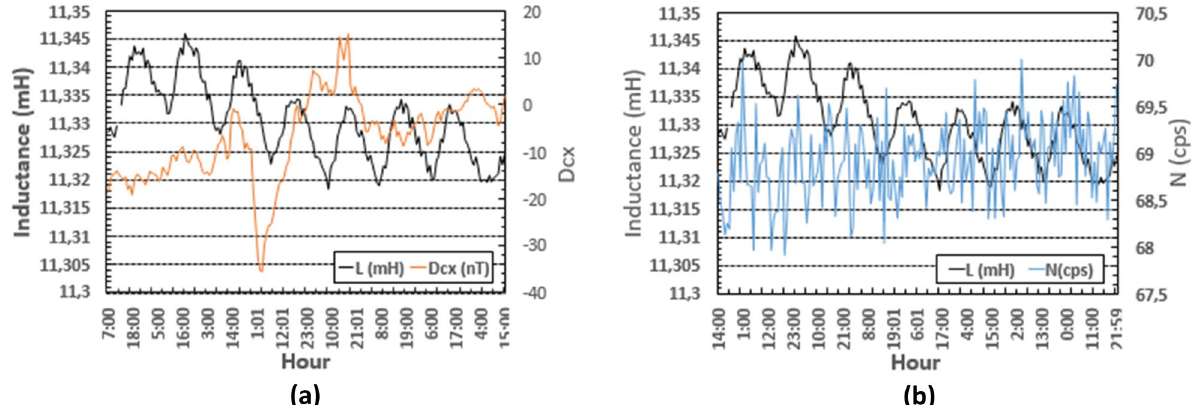
Figure 4. ( a ) Inductance versus Dcx, the latter ranging between − 25 and + 15 nT; ( b ) Inductance versus N, where N < 70 cps. Plots in ( a ) and ( b ) are obtained on an hourly basis (means were calculated every hour). The variability of Dst and N resembles the circumstances when there was lack of correlation with the DUT.